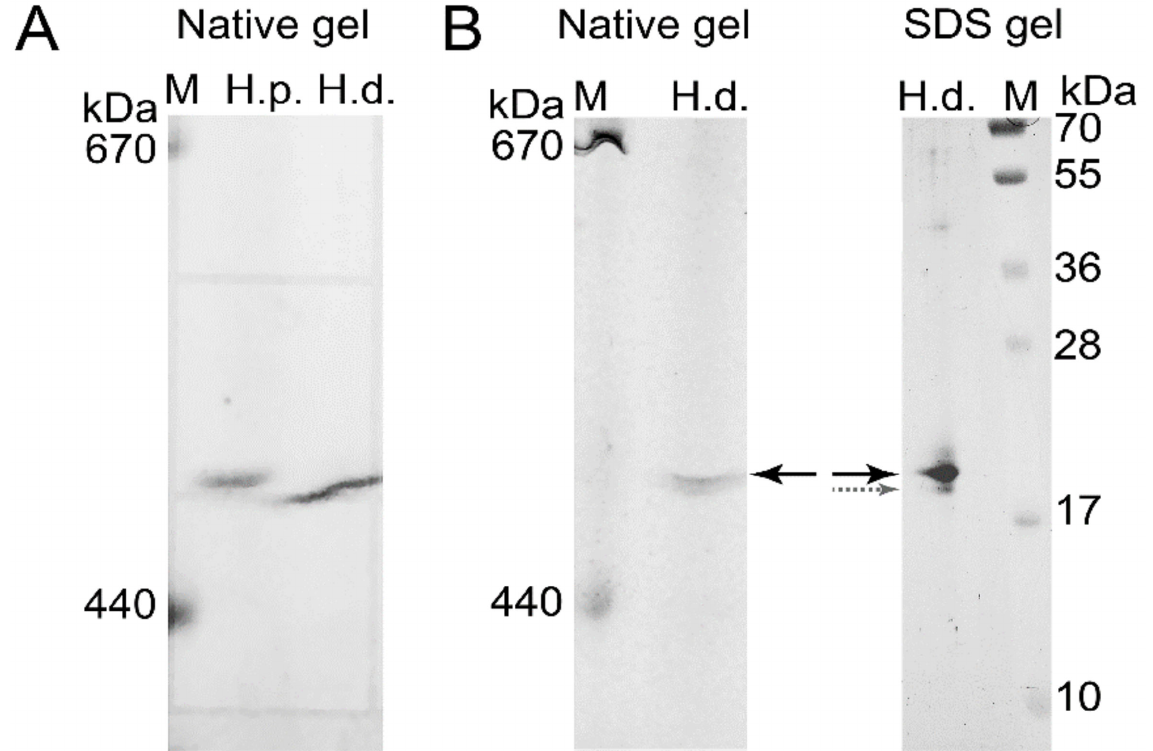
Figure 7. Isolation of H. dujardini and H. panicea ferritins by electrophoresis in a native polyacrylamide gel for mass spectrometry. ( A ) The native polyacrylamide gel stained with Coomassie blue without fixation. ( B ) The band corresponding to H. dujardini ferritin complex (marked by solid black arrow) was taken from the native gel, denatured, subjected to SDS-12% PAGE electrophoresis, and then stained with Coomassie blue. The major and minor bands indicated by solid black and dotted grey arrows were taken for MALDI/TOF mass spectrometry. M, horse ferritin (440 kDa) and thyroglobulin (670 kDa). H.p., H. panicea; H.d., H. dujardini